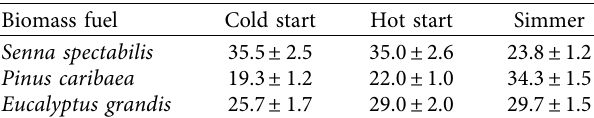
Figure 9: The specific fuel consumption of the tested biomass fuels. Table 4: Thermal efficiency (%) of the fire stove using the selected biomass